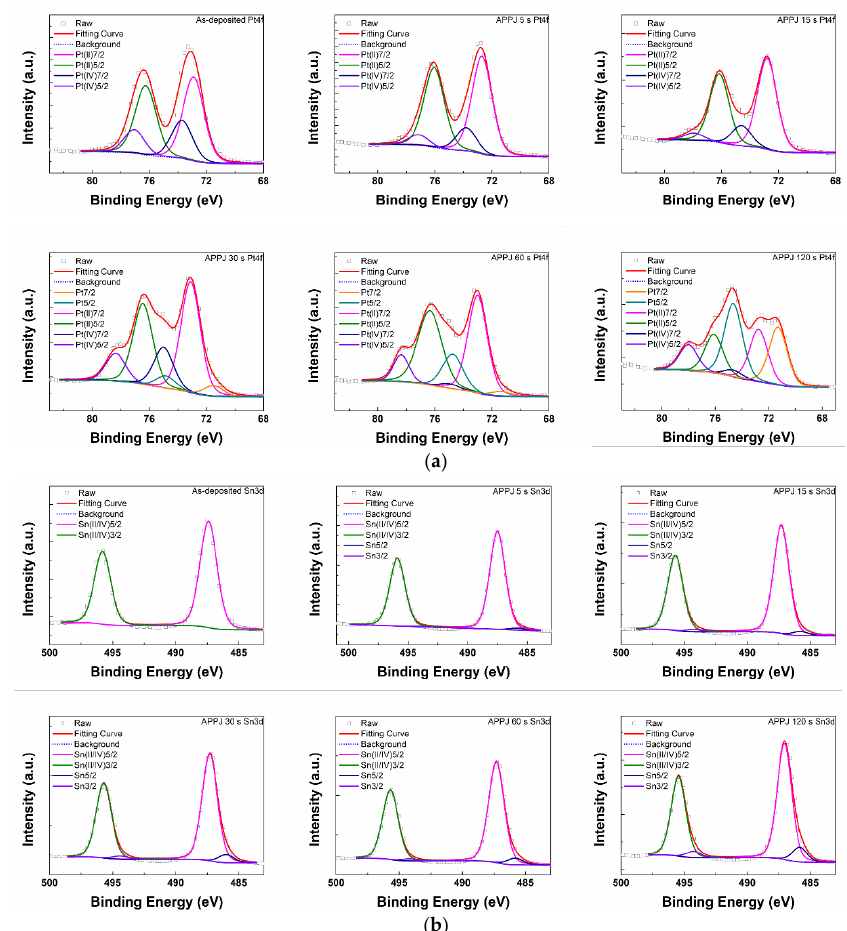
Figure 4. X-ray photoelectron spectroscopy (XPS) spectra of ( a ) Pt4f and ( b ) Sn3d for samples processed by APPJ for various durations. Table 1. Percentage of Pt species obtained from XPS analysis.